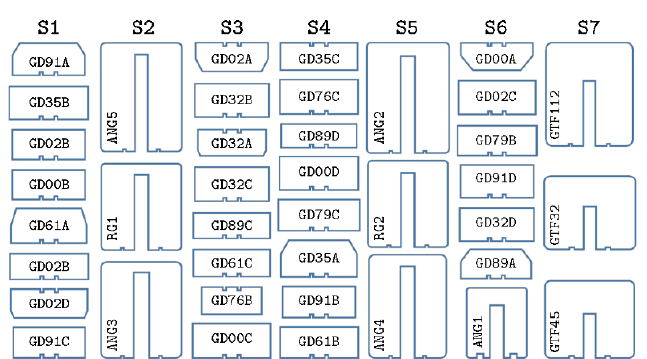
Figure 8. Detector string con(cid:12)guration in the Gerda array. Names pre(cid:12)xed with GD refer to detectors of enr BEGe type whereas ANG and RG refer to enr Coax detectors. The three natural coaxial detectors (pre(cid:12)xed with GTF ) which are located in the central string S7 are not used in this analysis.